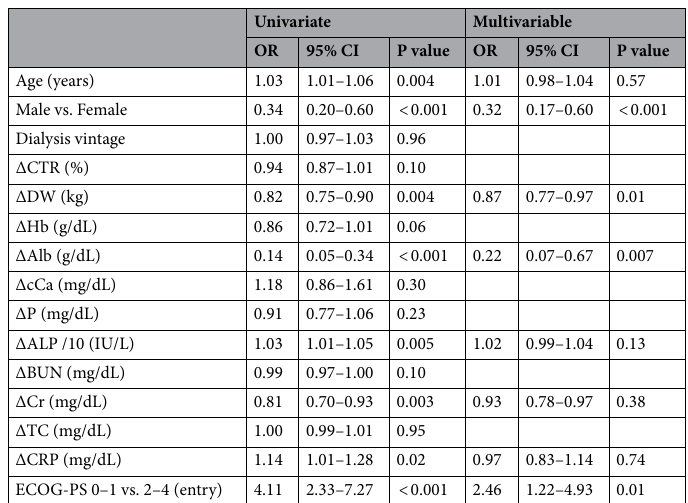
Table 4. Logistic regression model for Q4 of % change of psoas muscle index. OR odds ratio, CI confidence interval, CTR cardiothoracic ratio, DW dry weight, Hb hemoglobin, Alb albumin, cCa corrected calcium, P phosphate, ALP alkaline phosphatase, BUN blood urea nitrogen, Cr creatinine, TC total cholesterol, CRP C-reactive protein, ECOG-PS Eastern Cooperative Oncology Group performance